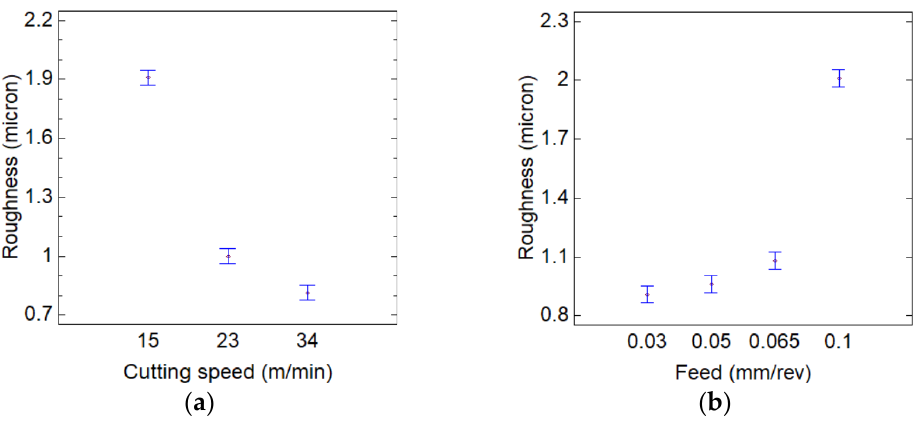
Figure 3. Means plots of the influences of the cutting speed and feed on the surface roughness: ( a ) roughness vs. cutting speed; ( b ) roughness vs. feed.